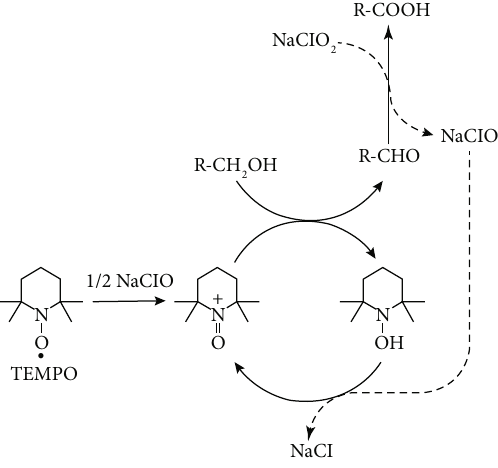
Figure 3: Oxidation of primary hydroxyls to carboxyls by the TEMPO/NaClO/NaClO system under weak acidic or neutral 2 conditions